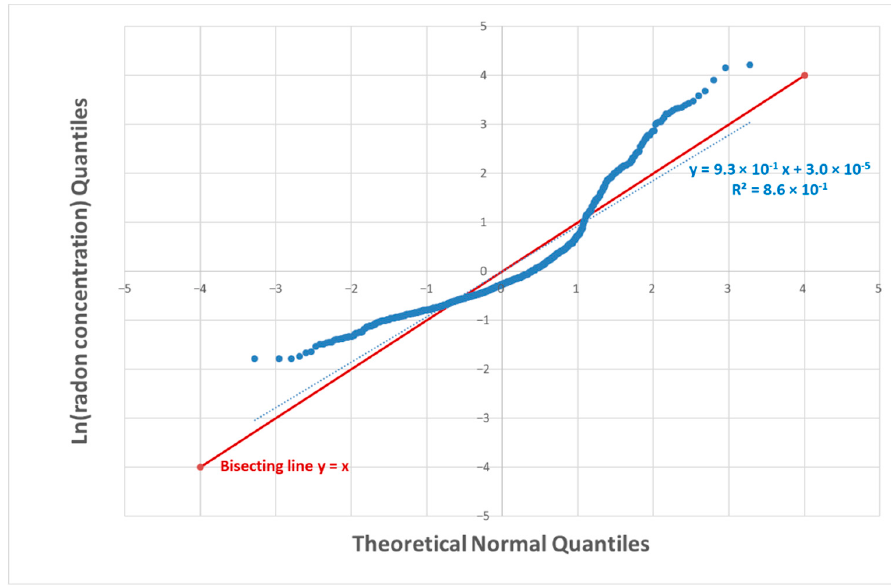
Figure 3. Q-norm plot of natural log-transformed annual radon activity concentration values of 963 rooms (dot plot) and the corresponding linear fitting (dotted line). The equation with R 2 value of the linear fitting and the bisecting line (continuous line) are also shown.